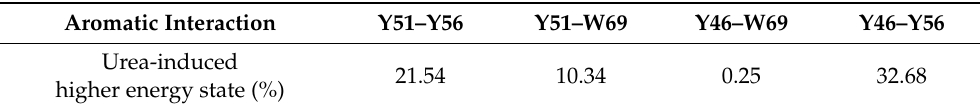
Figure 7. Minimal distance between the residues participating in the newly formed aromatic cluster in motif 2 of the urea-induced structure as a function of simulation time (left panel). Dash lines denote aromatic-aromatic residue interaction range found in most proteins [34]. Snapshot of the urea-induced structure taken at an 81-ns time frame (right panel) showing the relative positions of the residues (Y46, Y51, Y56, W69 in yellow, stick representation) forming the new aromatic cluster. Table 2. Percentage of aromatic–aromatic interactions present in the new aromatic cluster formed in motif 2 of the urea-induced higher-energy-state structure during 100 ns of simulation time, 425 K. Aromatic